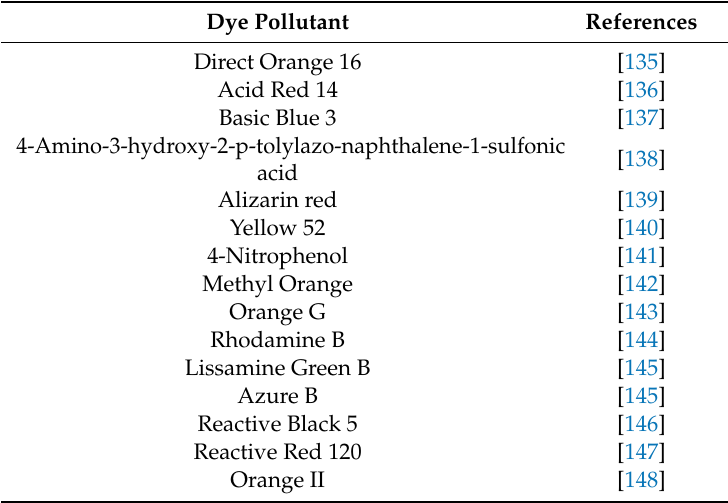
Table 2. Degradation of dyes by an electro-Fenton process in various